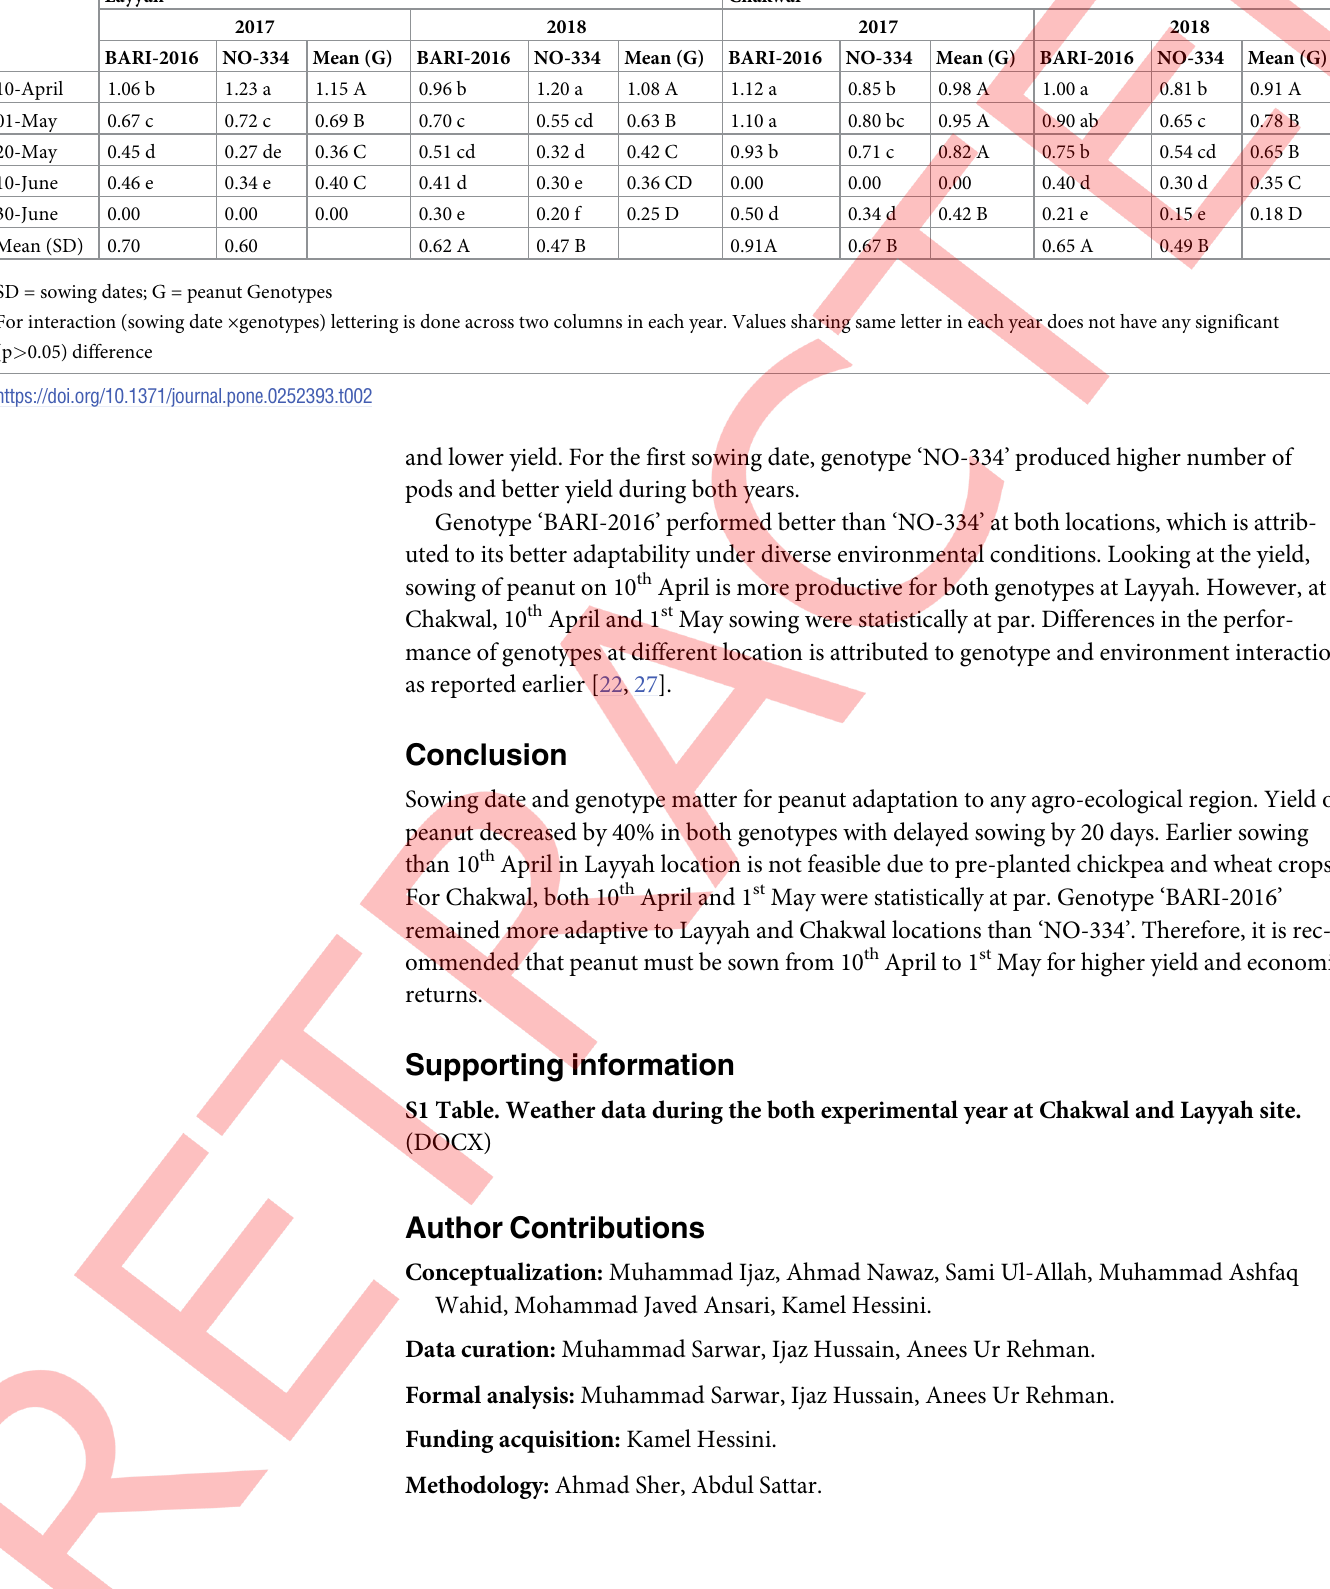
Table 2. Influence of sowing date and genotype on seed yield (tons/ha) of peanut grown under semi-arid subtropical climates (Layyah) and rainfed arid subtropical climate (Chakwal).